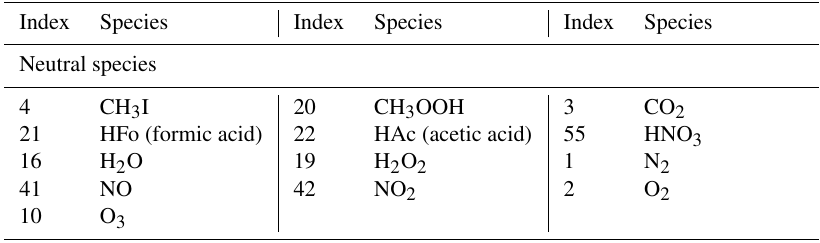
Table A1. Ion and neutral species alphabetically sorted by